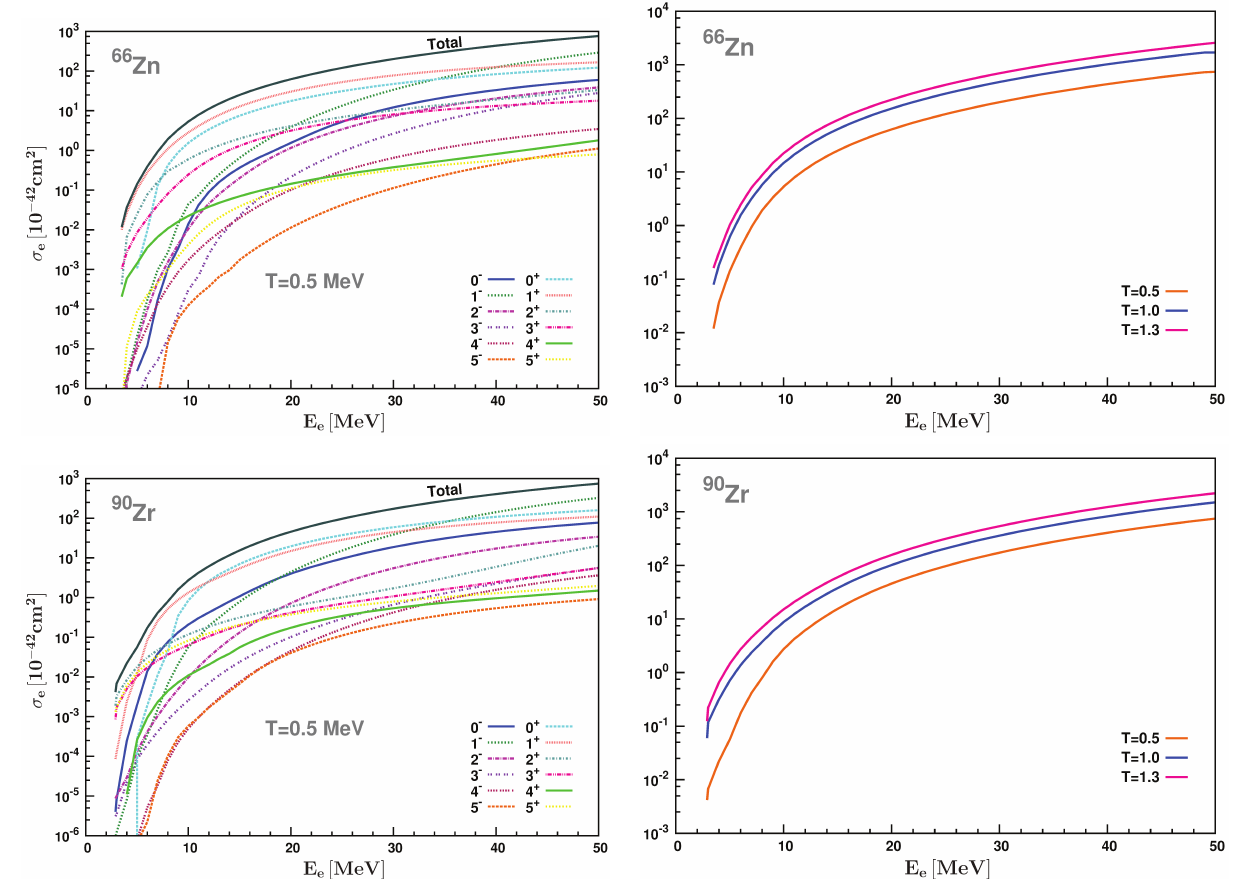
Figure 2. The same as Figure 1, but for the parent nuclei 66 Zn and 90 Zr . Moreover, the right panels show the temperature dependence of the cross-sections on these